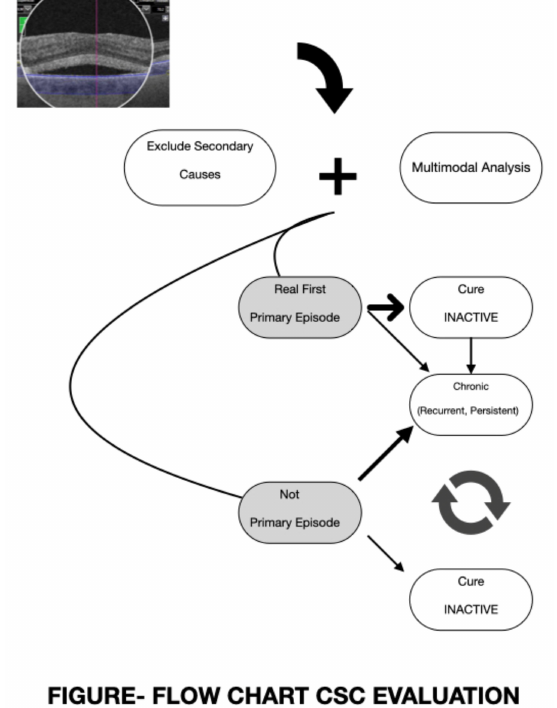
Figure 1. Basic steps: (1) define if your patient has a real first one episode or not and (2) a first episode can go to complete resolution (long-term follow-up) or become recurrent or persistent (chronic disease). In “not primary episode,” three options are possible: (1) become inactive, (2) evolve like a refractory disease, or (3) evolve in a cyclical